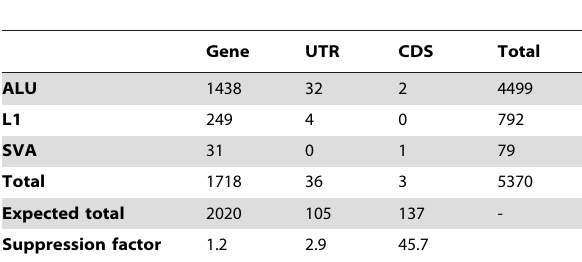
Table 2. Counts of non-reference MEI contained by annotated function regions.